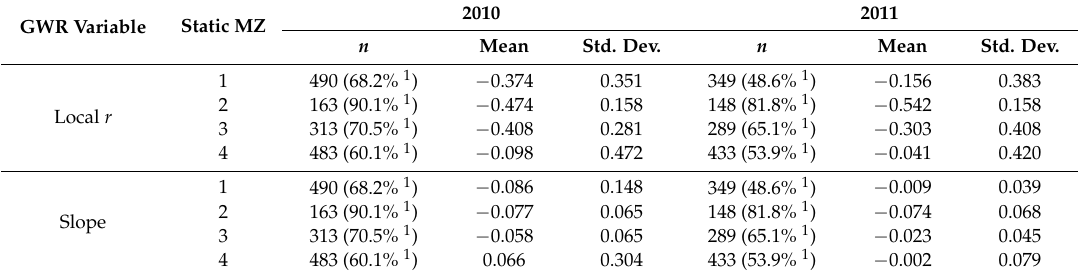
Table 4. Mean, standard deviation (Std. Dev.), and count ( n ) for the correlation coefficient ( r ) and slope obtained from significant geographically weighted regressions (GWRs) for the static management zones (MZs) delineated using soil apparent electrical conductivity for the 0–1.5-m soil profile (EC a Deep) only. GWR